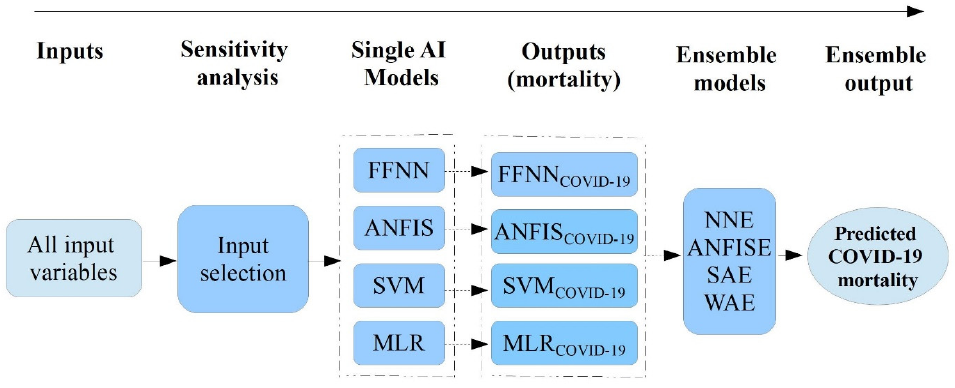
Figure 5. Diagram of the ensemble